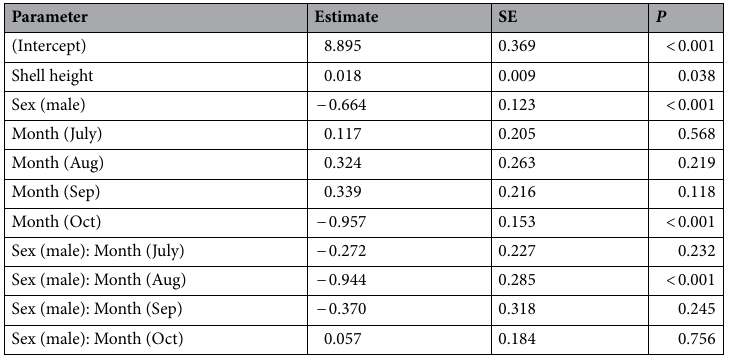
Table 2. Summary (coefficient) of the selected generalized linear mixed model (Gaussian family and identity- link function) for body mass index of collected Laguncula pulchella individuals with shell height ≥ 25 mm. Data from June to October were used. All initial explanatory variables were included in the selected model, based on the Akaike information criterion (AIC). The effects of month and sex were evaluated on the basis of "June" and "female",